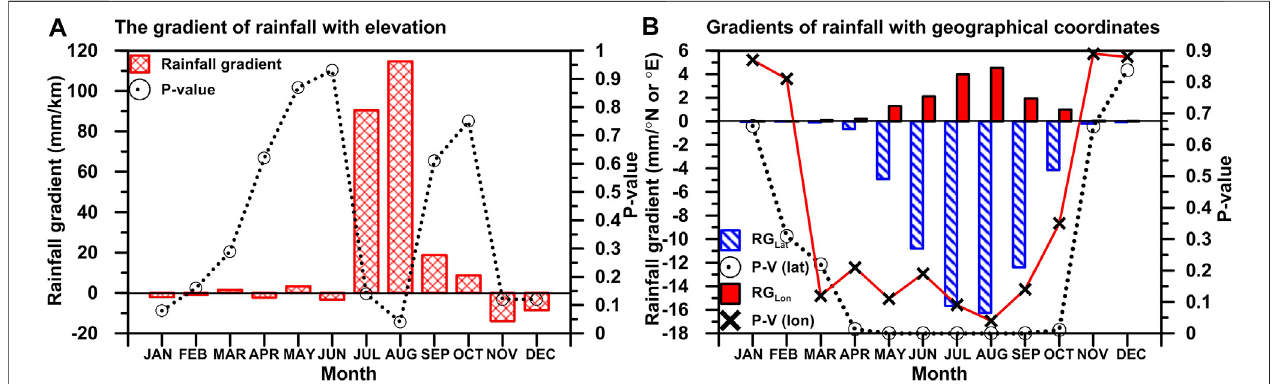
FIGURE 7 | Monthly variations in rainfall gradients and their signi fi cance values as a function of elevation (A) and geographical coordinates (B) .